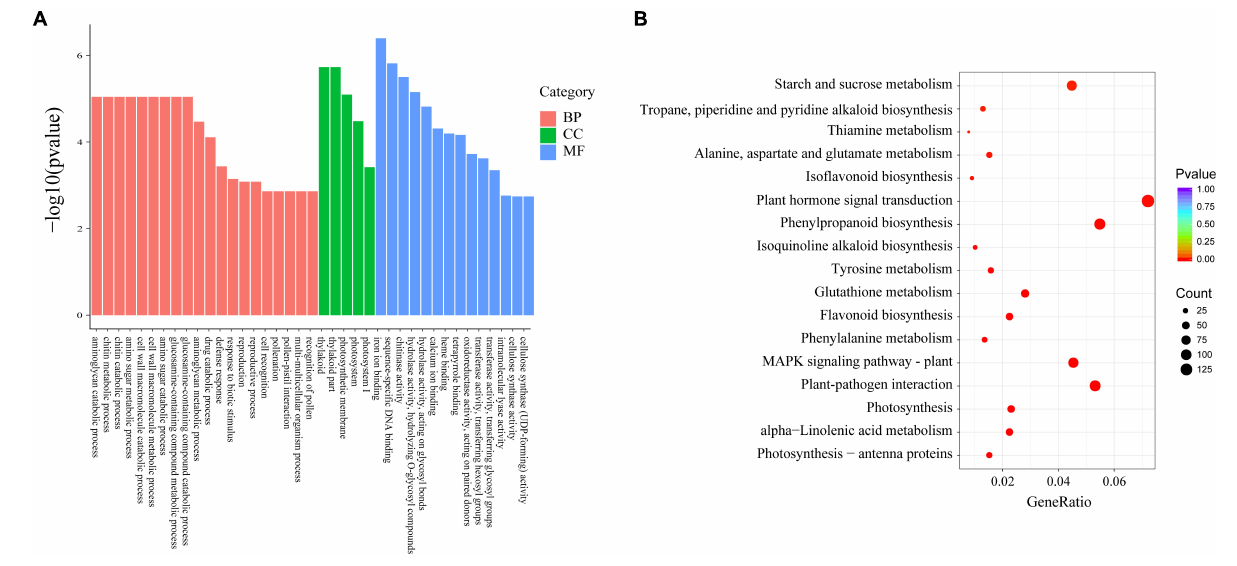
and blue modules. A total of 334 DEGs were associated with resistance in the three significantly related